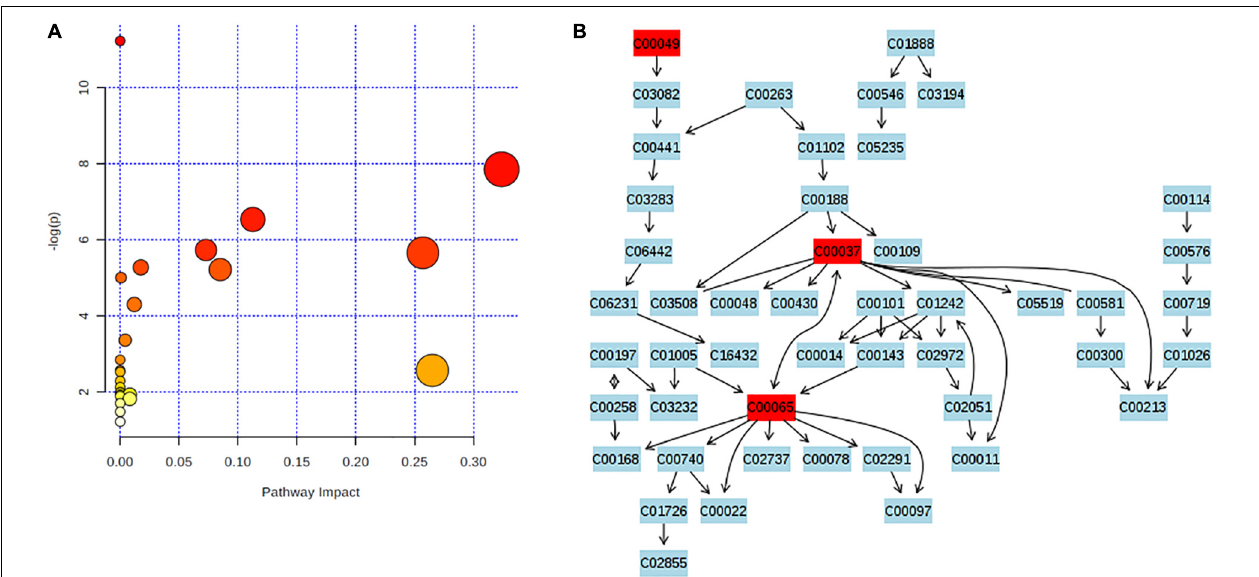
FIGURE 3 | Enrichment analysis of metabolic pathway. (A) P -values were obtained by Holm–Bonferroni correction and FDR correction. The rightmost dot was the pathway of glycine, serine, and threonine metabolism. (B) Glycine, serine, and threonine metabolism was identified as metabolite pathway with significance in PQ3d vs. Ctrl. Identified metabolites involved in this pathway were highlighted in red. C00049: L -aspartic acid; C00037: glycine; C00065: L -serine.